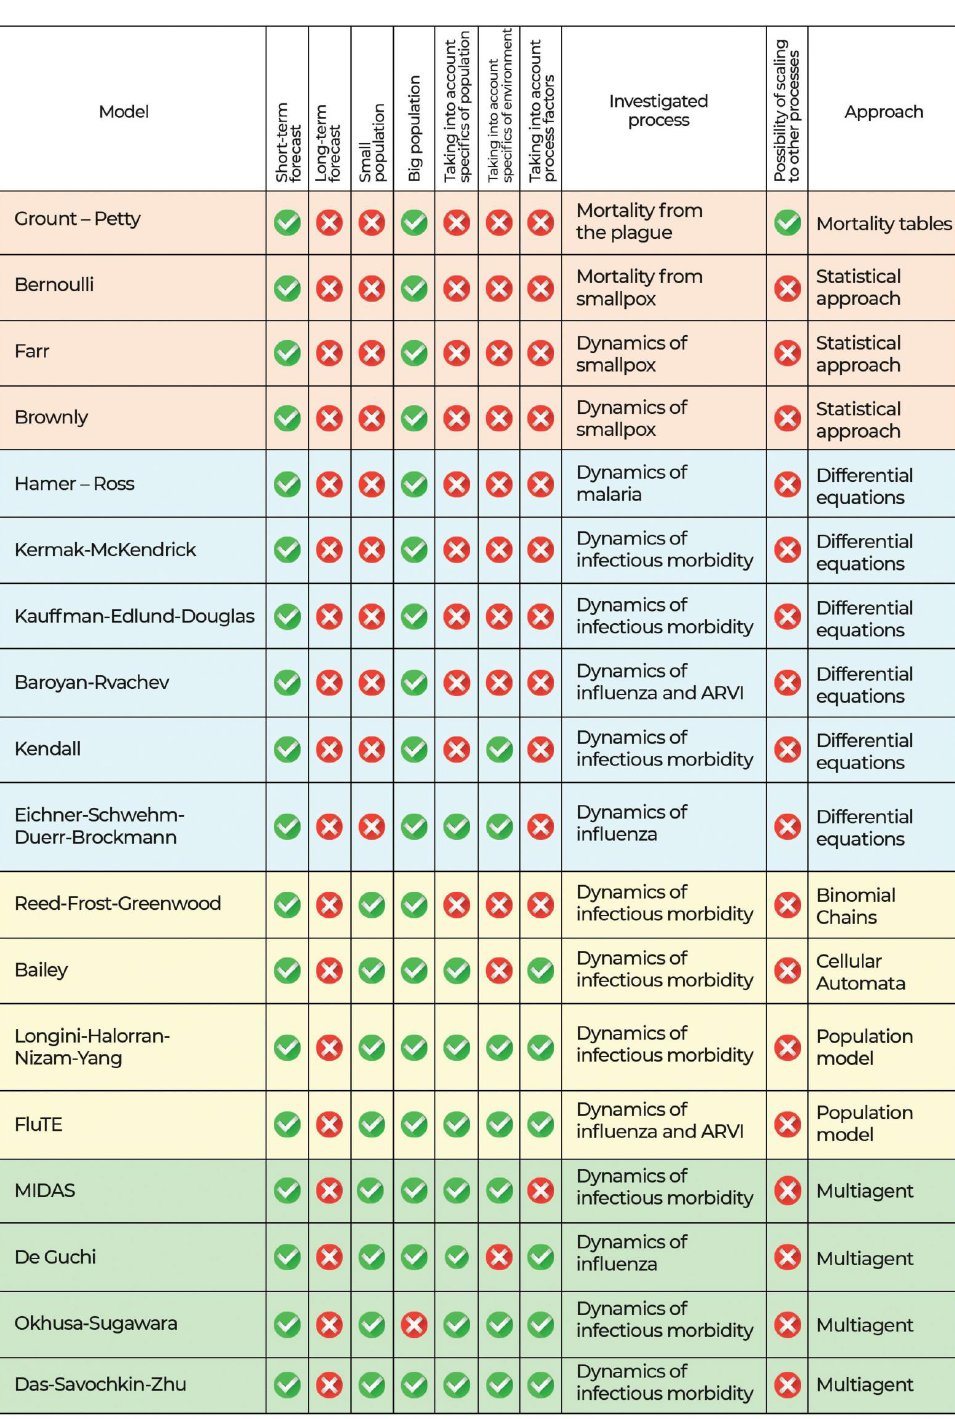
Figure 1. Results of analysis of epidemic processes simulation.